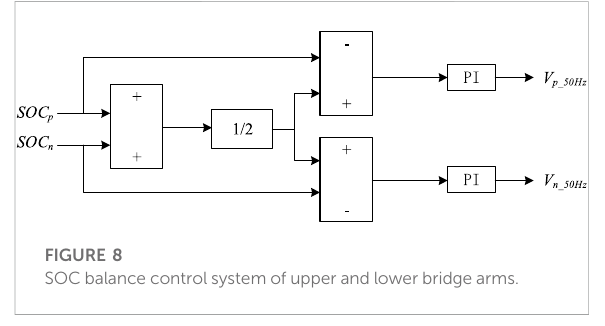
FIGURE 8 SOC balance control system of upper and lower bridge arms.